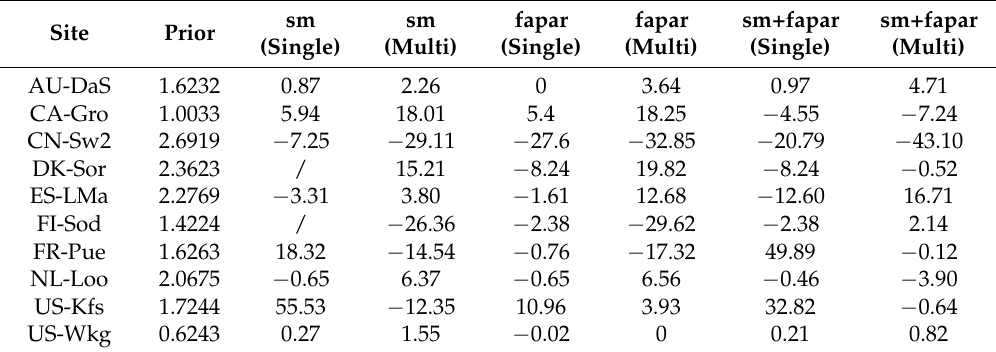
Table 6. RMSE relative changes (%, positive values mean RMSE was degraded) for net ecosystem productivity (NEP) in comparison with prior simulations, ‘sm’ with soil moisture solely, ‘fapar’ with FAPAR solely, ‘sm+fapar’ with combination of soil moisture and FAPAR data, ‘multi’ denotes multi-site assimilation, and ‘single’ denotes single-site